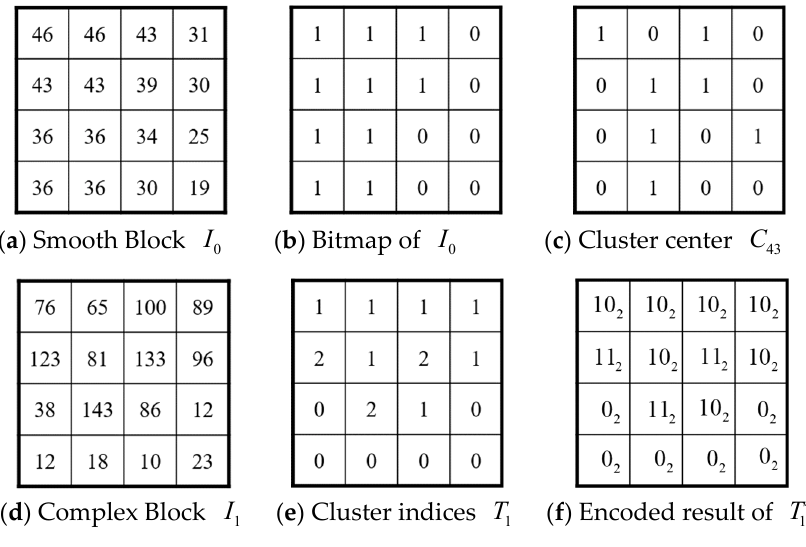
Figure 2. An example of image encoding.